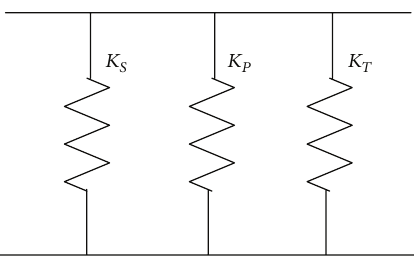
Figure 1: The equivalent stiffness of piezoelectric